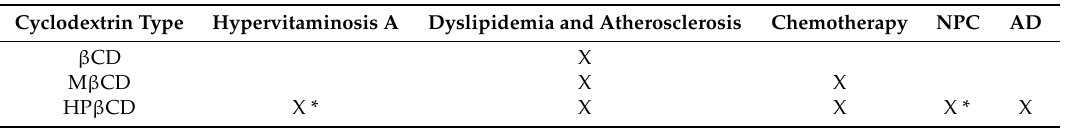
Table 2. Types of cyclodextrins that have been investigated as possible active pharmaceutical ingredients in vivo (and in humans